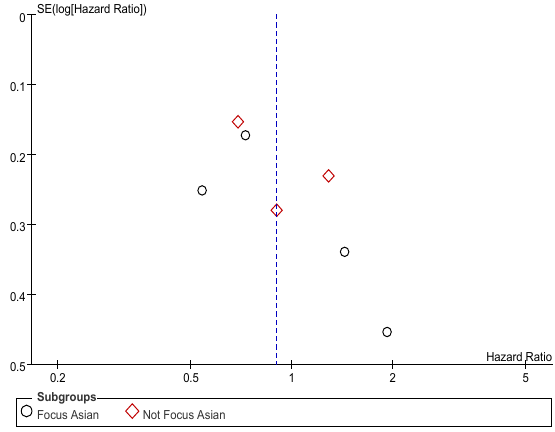
Figure A8. PFS comparisons among never smoker stratified by ethnicity.